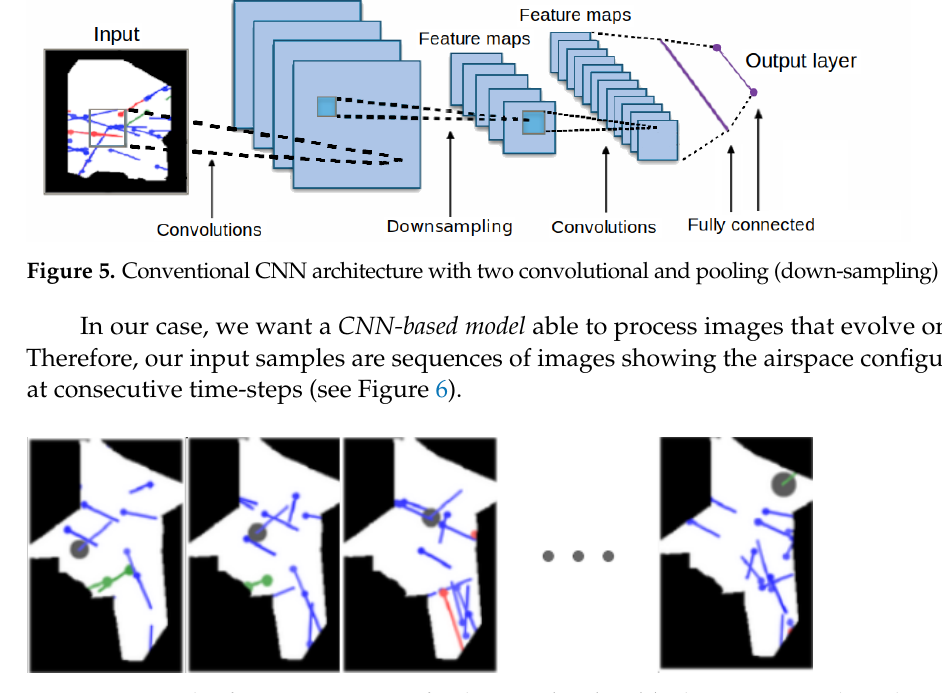
Figure 6. Example of an input sequence for the CNN-based model . The grey points show the path of a unique aircraft. Notice that only four time-steps are shown by simplicity, but the complete sequence contains 30